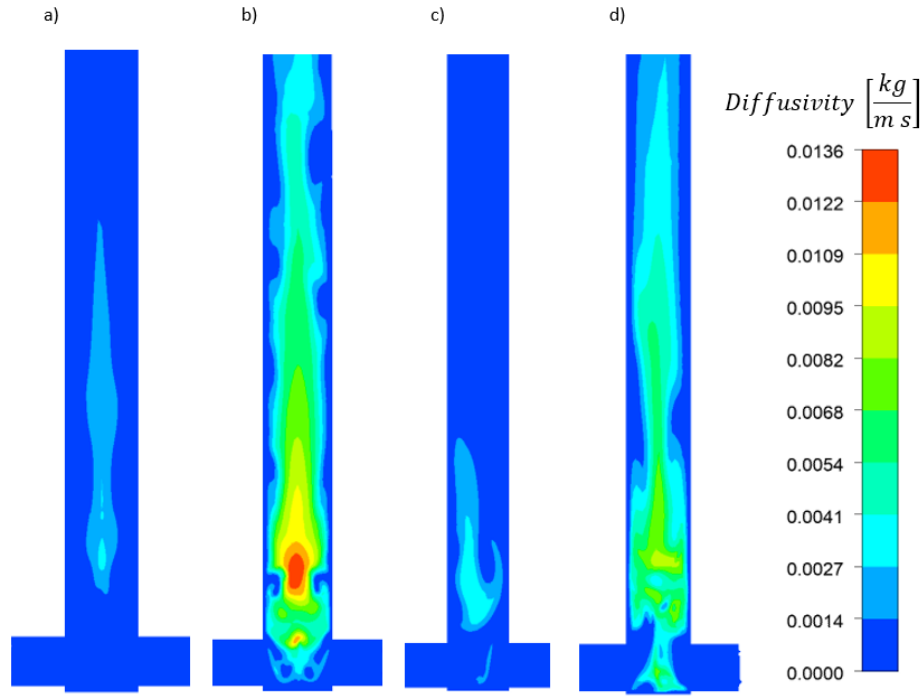
Figure 9. Diffusivity [kg m − 1 s − 1 ] contours for 0.6 mol/dm 3 AS in V-type reactor at ( a ) 20 and ( b ) 50 mL/min flow rates and in T-type reactor at ( c ) 20 and ( d ) 50 mL/min flow rates.